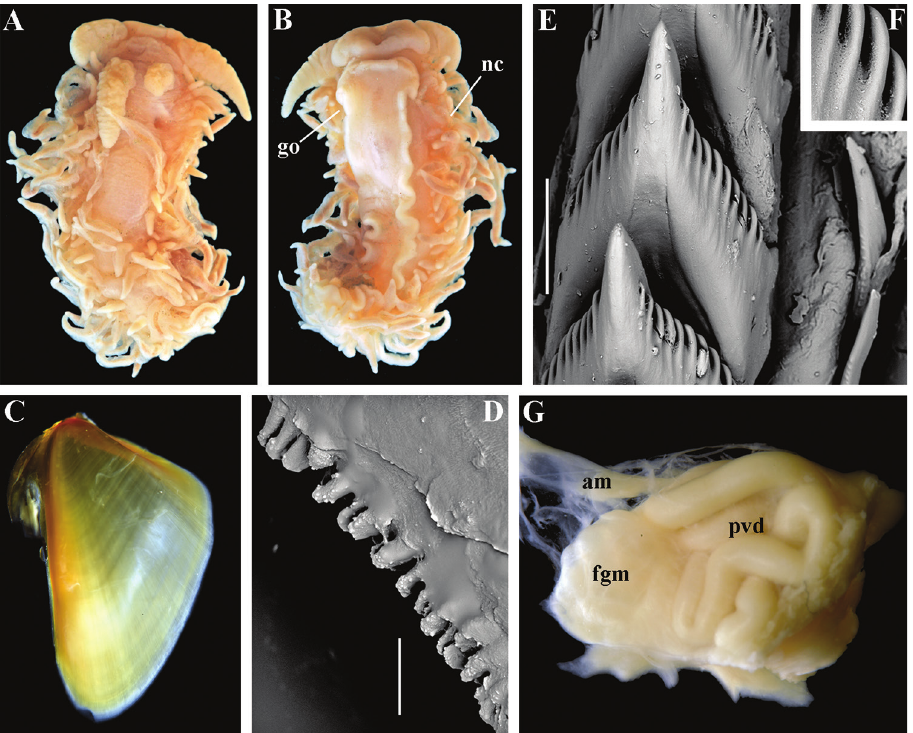
Figure 14. Ziminella japonica (Volodchenko, 1941), comb. n.: A ZMMU Op-261, (Sea of Japan, 470– 528 m) dorsal view, 8.3 mm in fixed length B same, ventral view C jaw, light microsocopy D details of mastica- tory process of jaws, SEM E radular teeth, posterior part F details of rachidian radular tooth G reproductive system, light microscopy. Abbreviations: am ampulla fgm female gland mass go genital opening nc continu- ous notal edge pvd prostatic vas deferens. Scale bars: D = 30 μm; E = 100 μm. Photos and SEM images by A.V.